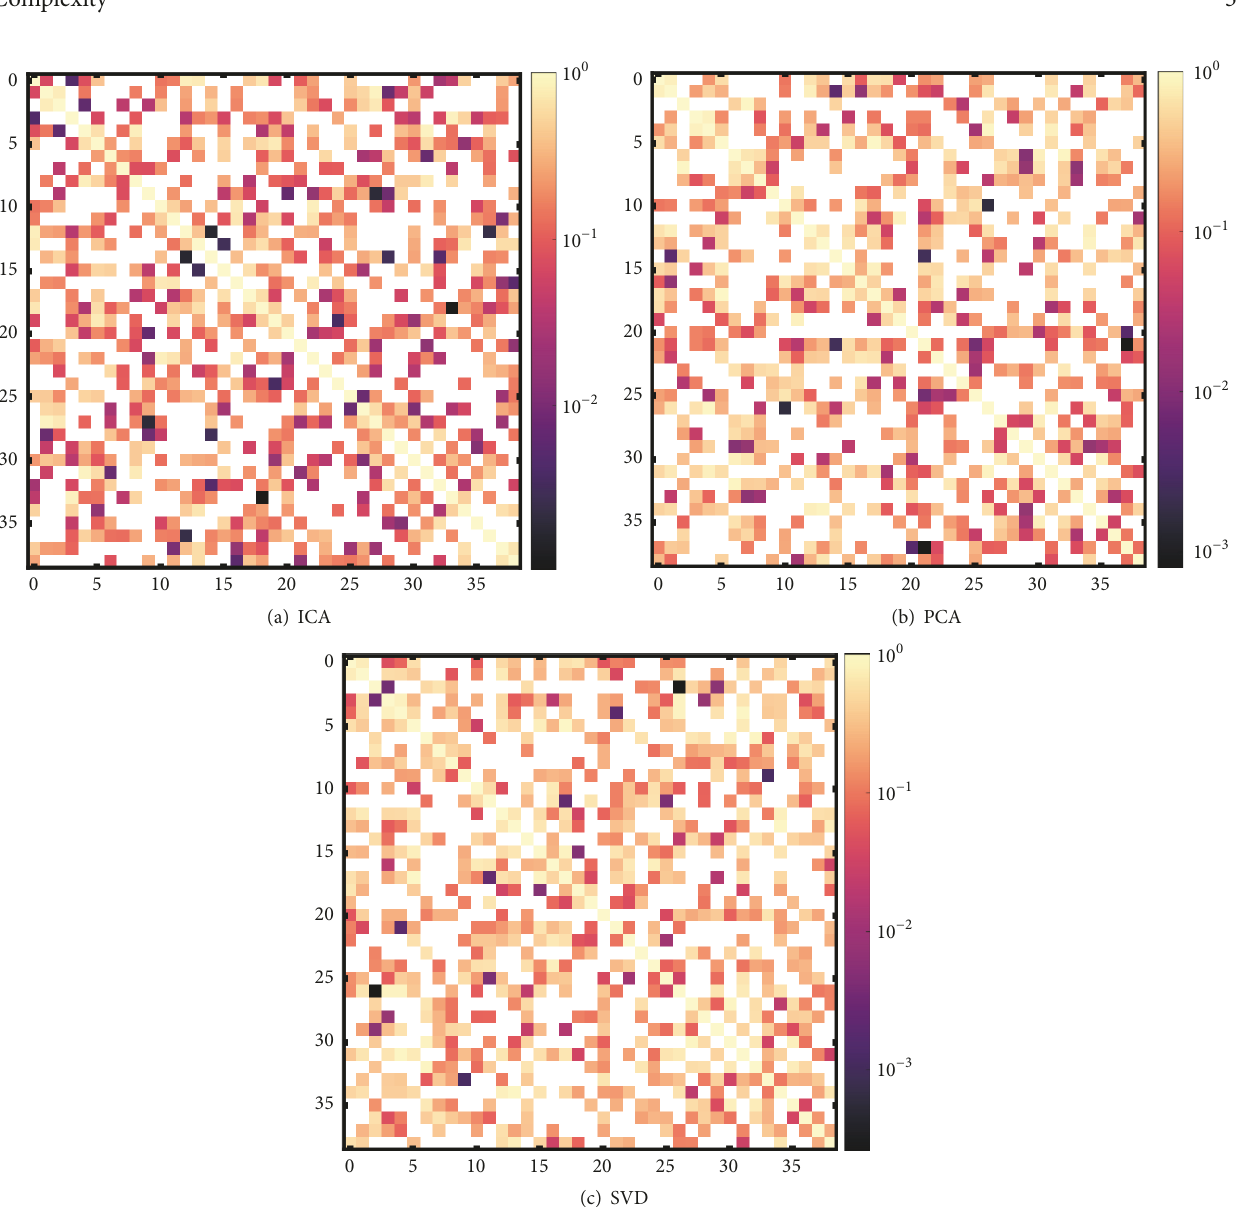
Figure 3: Illustration of correlation matrices with 10 components for ICA, PCA, and SVD data reduction